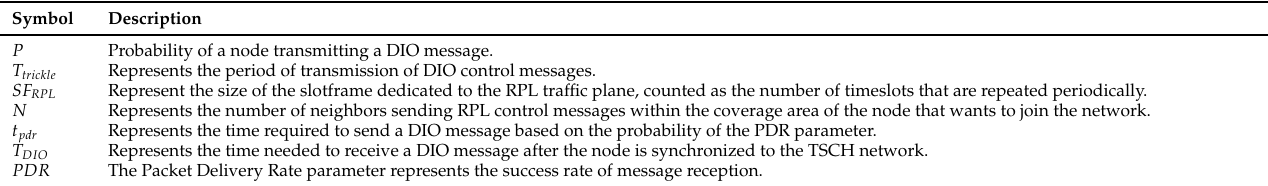
Table 2. RPL analytical model